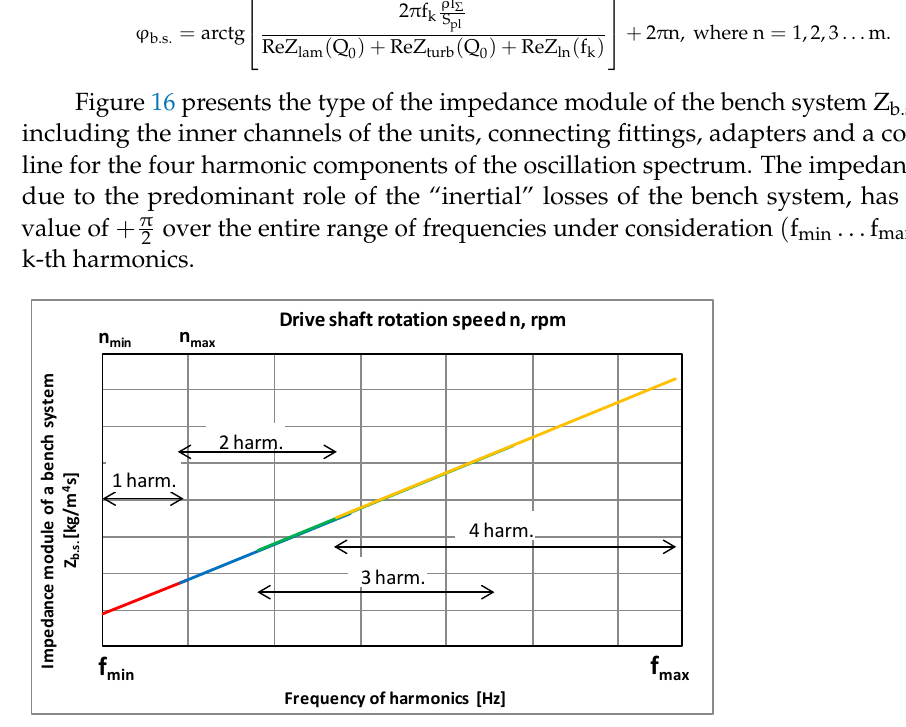
Figure 17. ISO 1219 scheme of the bench system implementing the capacitive load impedance at the liquid output from the pump: 1—pump; 2—cavity volume; 3—load throttle; 4—flow sensor; 5 and 6—connecting fittings and 7—pressure sensor. We can see the calculation model of such a system in the form shown in Figure 18.